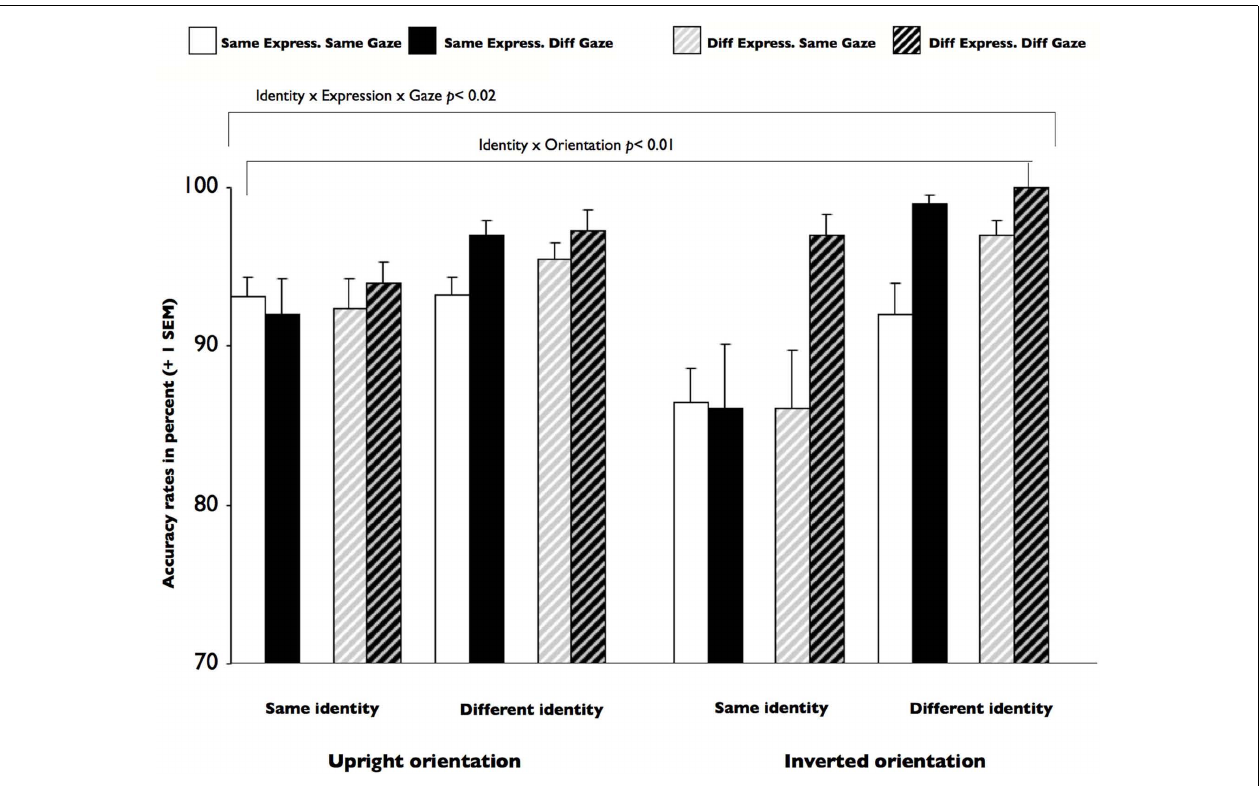
FIGURE 3 | Experiment 1: overview of the mean accuracy rates for all conditions for both orientation blocks. Additional parentheses highlight significant F -tests (interactions and main effects, not t -tests).The three-way interaction for identity × gaze × orientation for the accuracy rates was